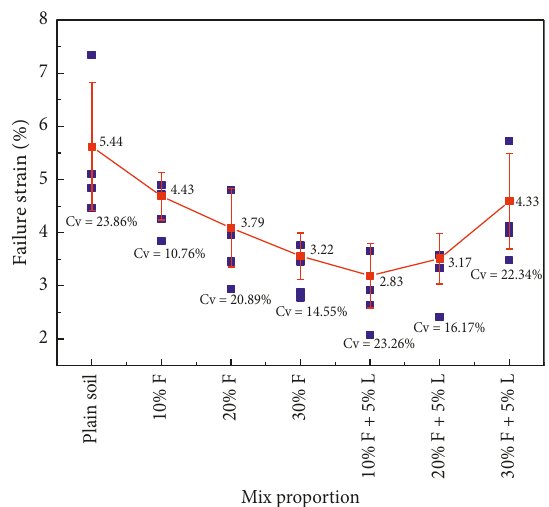
Figure 18: Brazilian splitting failure strain curve of stabilized soil (28 days).